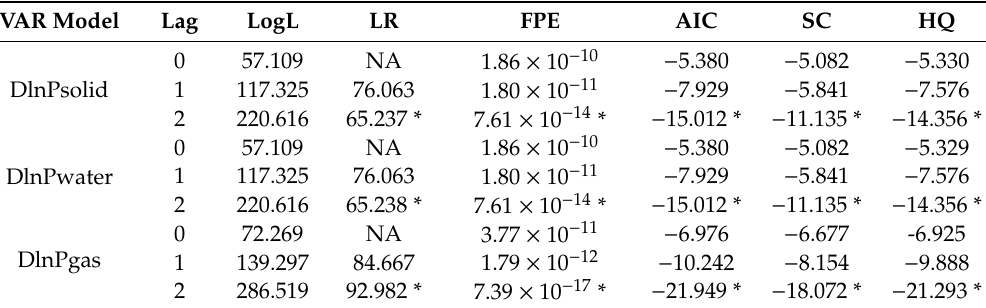
Table A2. The results of optimum lag